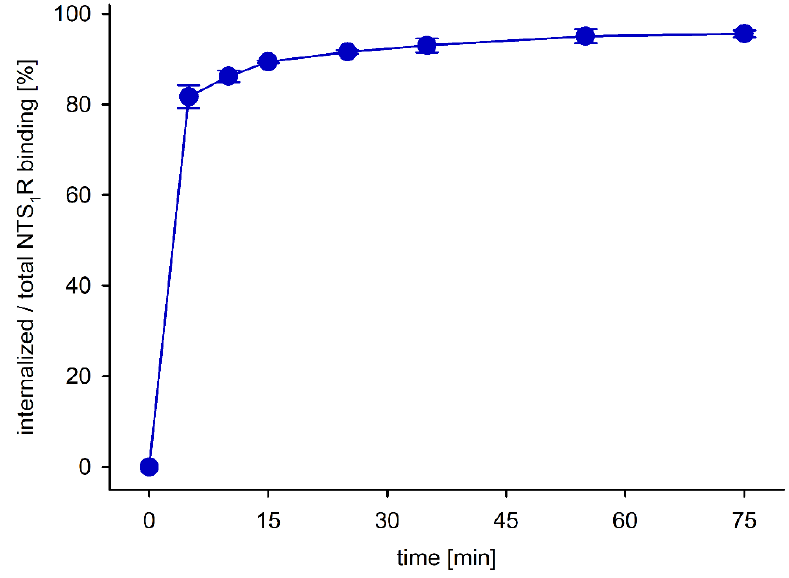
Figure 6. Fraction of specifically bound and internalized [ 68 Ga] 56 in HT-29 cells relative to the entire specific binding determined at 37 °C. Given are mean values ± SD of two independent experiments, each performed in triplicate.